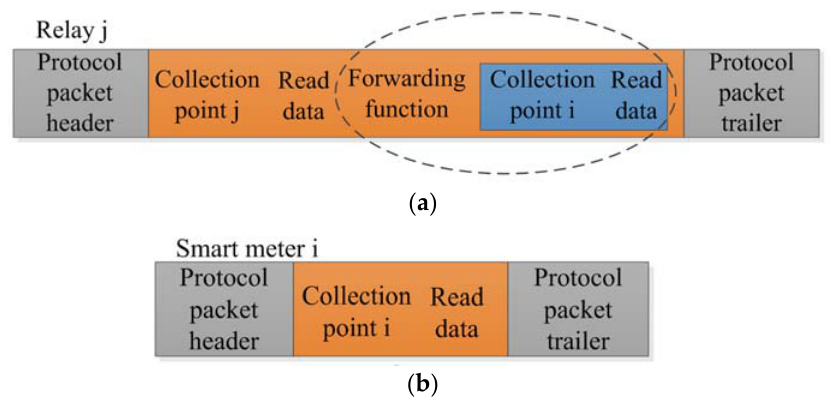
Figure 5. The protocol format. ( a ) Smart meters which have relay function; ( b ) Smart meters which have not relay function.